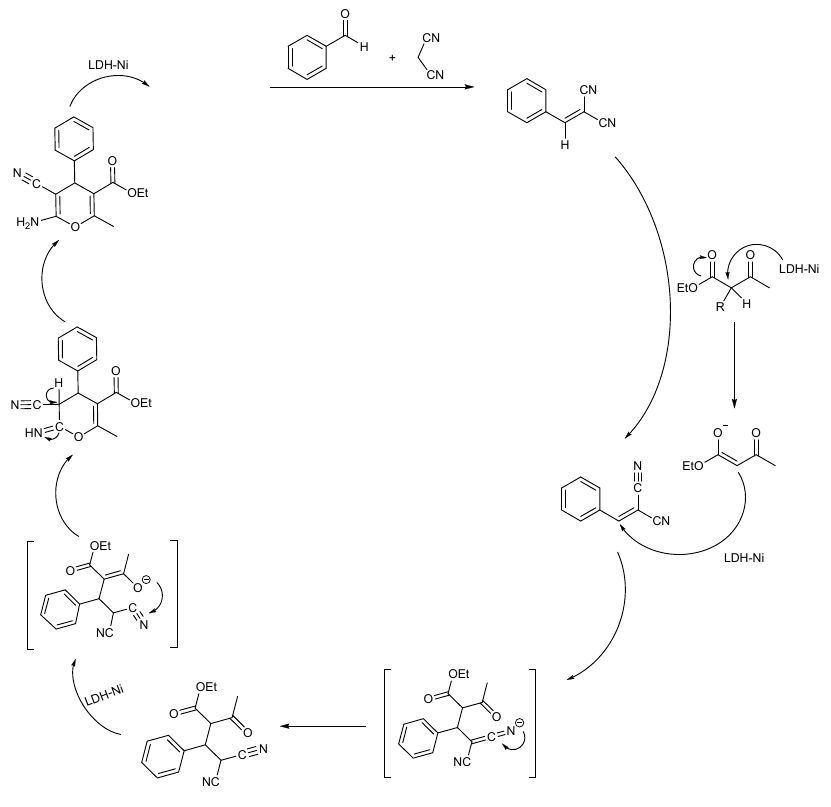
Scheme 2. 4 H -pyrans reaction mechanism.